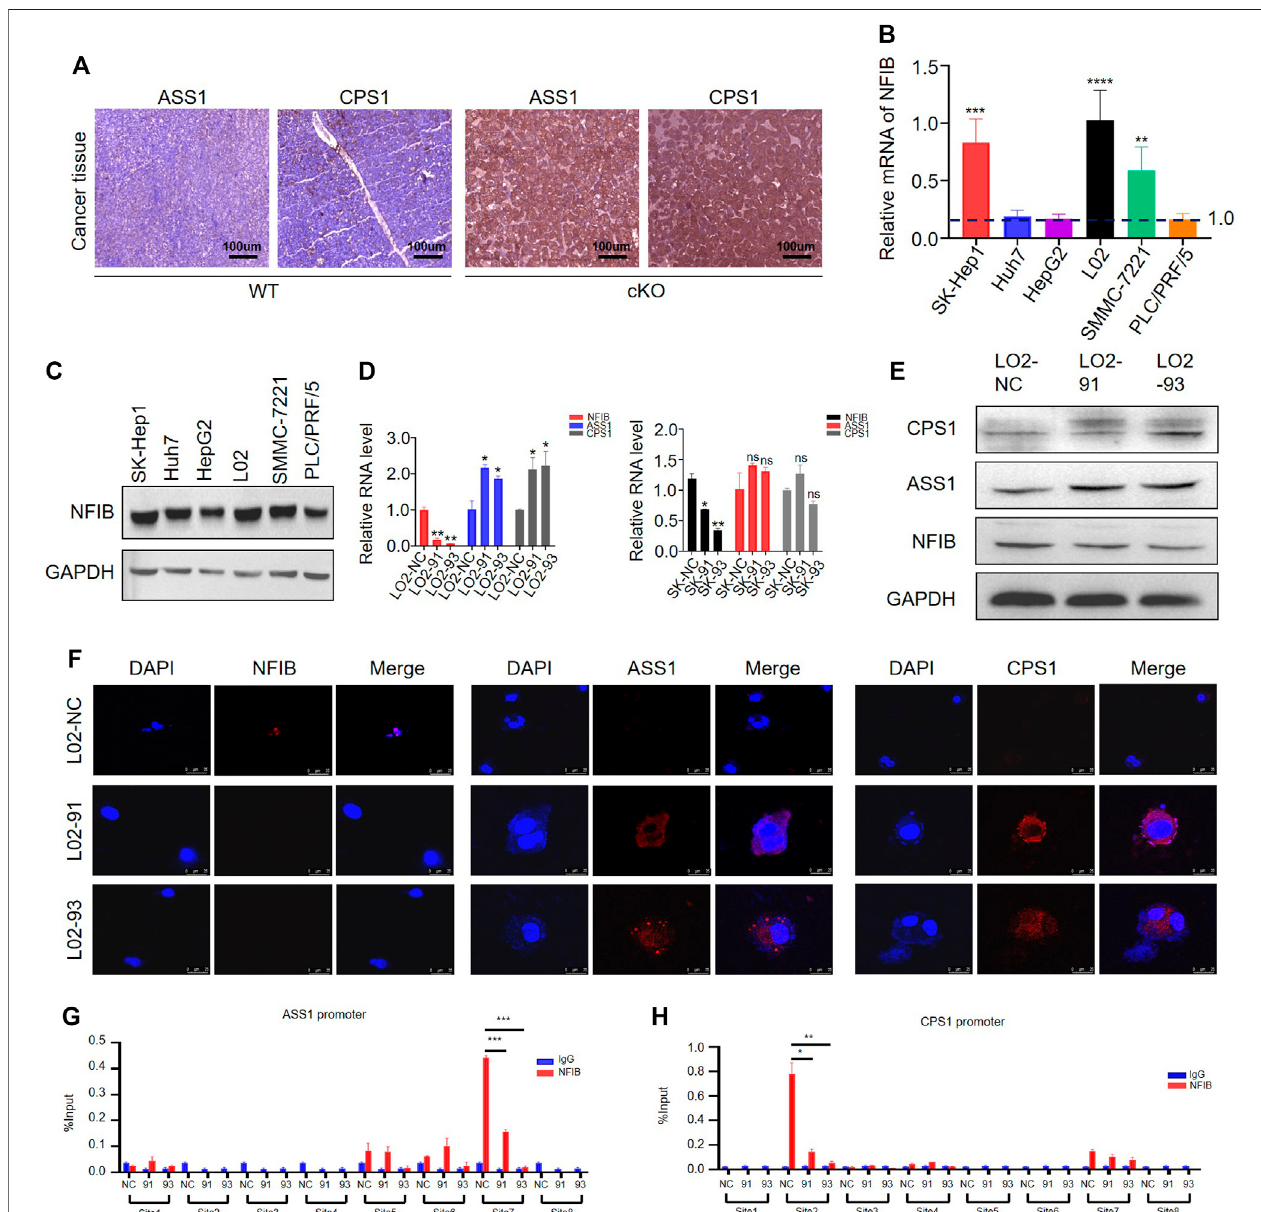
FIGURE5| NFIB inhibitsCPS1 and ASS1expression inhepatocytes. (A) IHC stainingshows thatbothCPS1 and ASS1areupregulated inN fi b − / − cancerliver. (B) The expression level ofNFIB in HCC cell lines and L02 by RT-PCR. (C) The expression level of NFIB in HCC cell linesand L02 byWesternblot. (D) Knocking down NFIB signi fi cantlyincreasedtheexpressionofASS1andCPS1expressioninnormalhepatocyteL02byqPCR. (E) KnockingdownNFIBsigni fi cantlyincreasedtheexpression of ASS1 and CPS1 expression in normal hepatocyte L02 but not in SK-Hep1 cells by western blot. The NFIB knocking down cells with two different shRNAs were respectively designated as 91 and 93. The corresponding scramble one was assigned with NC. (F) Immuno fl uorescence staining showing the increased expression of ASS1 and CPS1. (G,H) ChIP assay for theASS1 and CPS1 promoters. L02 cells were transduced with NFIB-knockdown lentivirus or control, and ChIP was performed byIPwitheitheranti-NFIBantibody(red)orcontrolIgG(blue).Real-timePCRanalysisofrelativebindingaf fi nityofNFIBtotheeightbindingsitesinASS1promoterregion. ***, p < 0.001.Real-timePCRanalysisofrelativebindingaf fi nityofNFIBtotheeightbindingsitesinCPS1promoterregion.Allscalebars=100 μ m.Originalmagni fi cation × 20. *, p < 0.05; **, p <